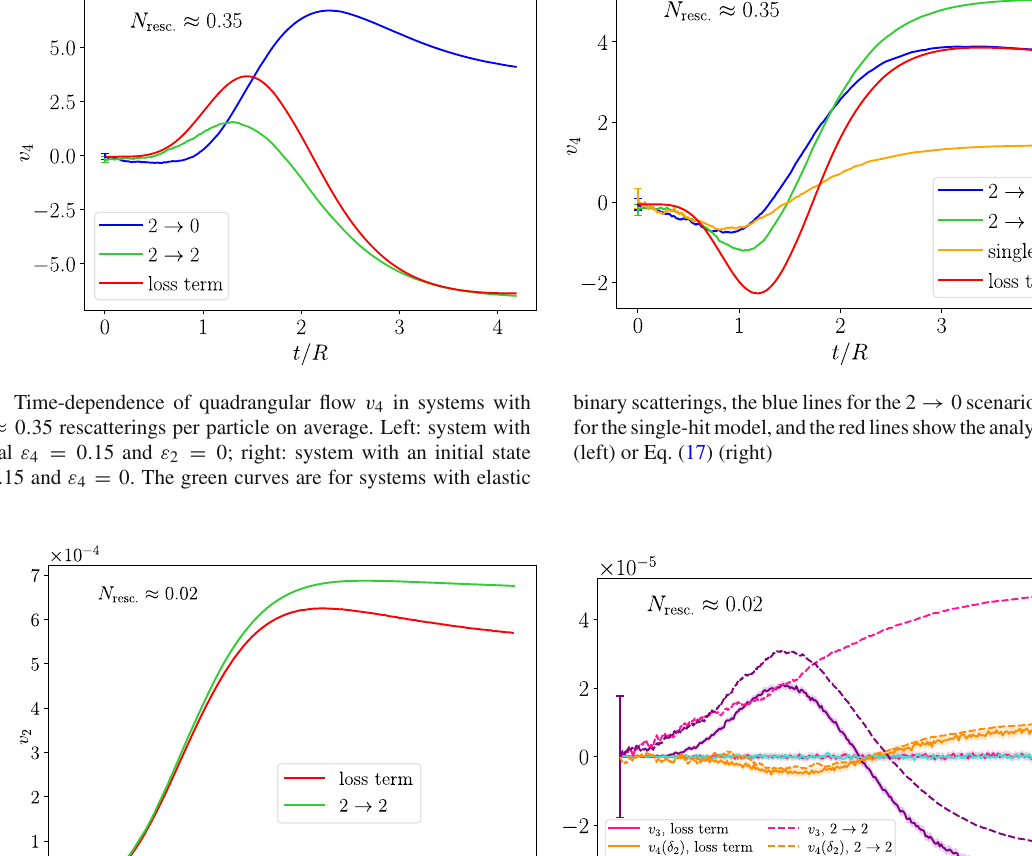
purple: for δ 4 = 0 . 15), and v 5 (cyan, for δ 5 = 0 . 15) in numerical sim- ulations (dashed lines) or computed with Vegas (full lines; the color bands show the 3 σ error of the MC